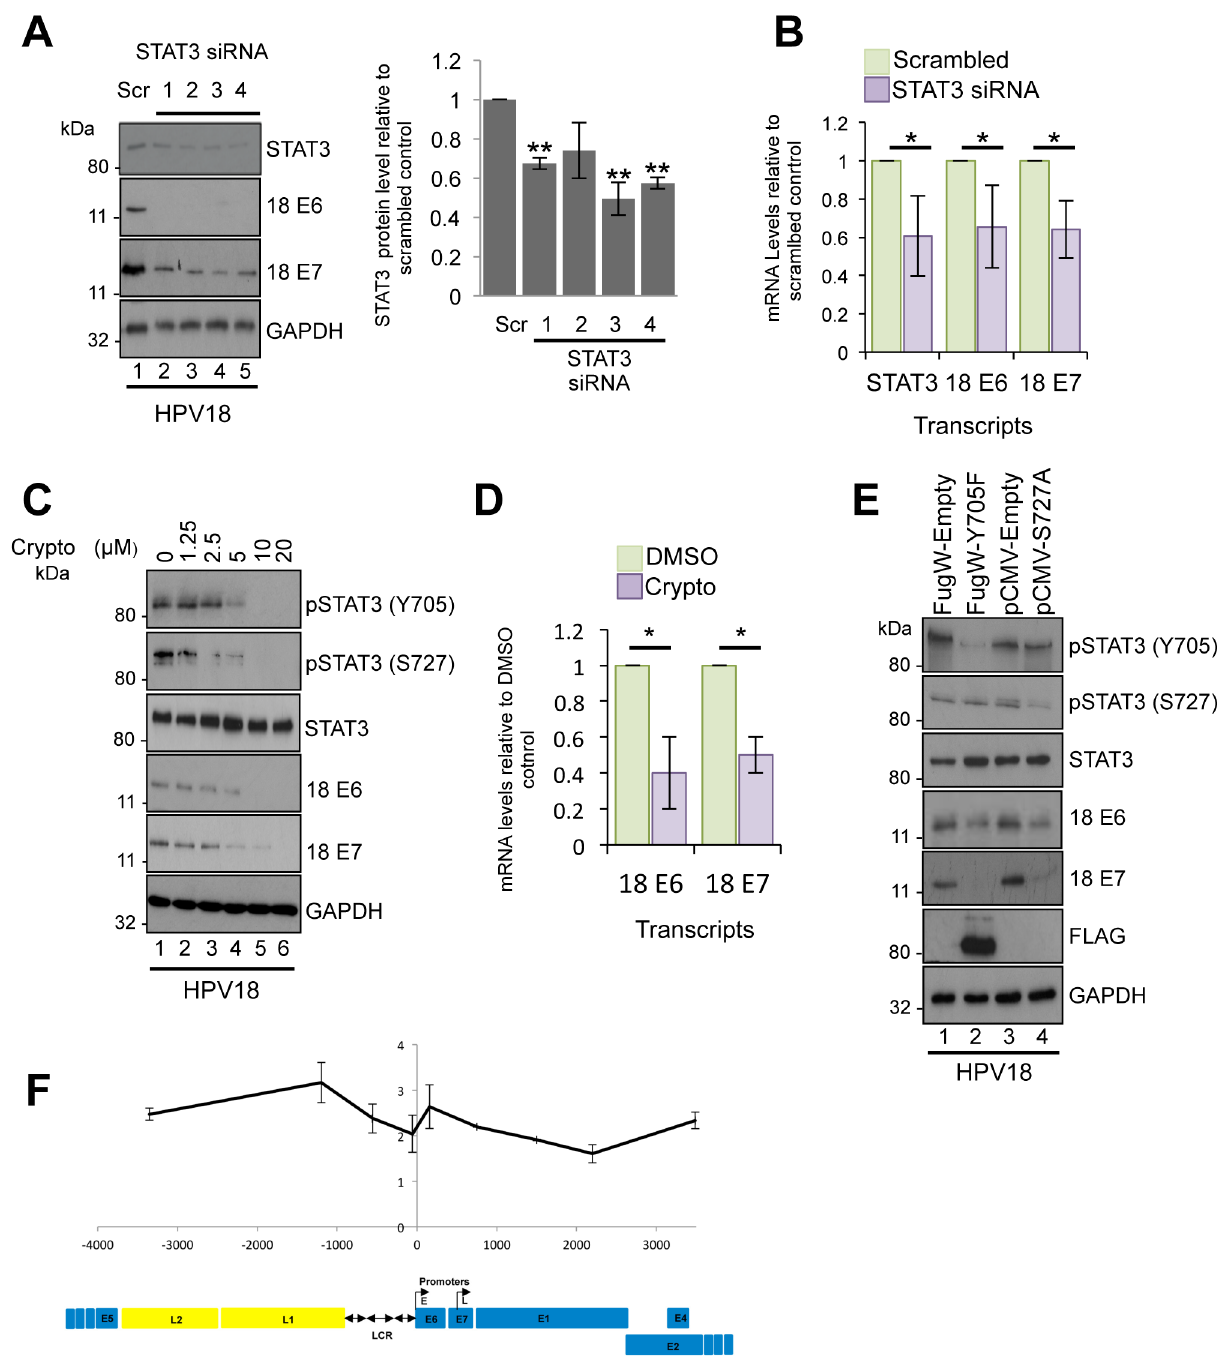
Fig 6. STAT3 is required for viral gene expression in undifferentiated keratinocytes. A) Left: Representative western blots of HPV18 containing keratinocytes transfected with a panel of 4 STAT3 specific siRNA and a scrambled control and analysed by western blotting using a total STAT3 antibody and antibodies detecting the E6 and E7 HPV18 early proteins. GAPDH served as loading control. Right: Quantification of the STAT3 protein band intensities standardised to GAPDH levels. Data are expressed as fold reduced compared to scramble siRNA treated cells. Bars represent the means ± standard deviation of at least three biological repeats. (cid:3)(cid:3) p < 0.01 (Student’s t-test). B) Samples treated as in (A) and RNA extracted for qRT-PCR determination of the stat3 and HPV early gene expression levels. Samples were normalized against U6 mRNA levels and data are presented relative to the scrambled control. Bars represent means ± standard deviation of at least three biological repeats. (cid:3) P < 0.05 (Student’s t-test). C) Representative western blots from HPV18 containing keratinocytes treated with increasing doses of the STAT3 inhibitor cryptotanshinone and analysed with antibodies specific for phosphorylated and total STAT3, and E6 and E7 HPV18 early proteins. GAPDH served as a loading control. Data are representative of at least three